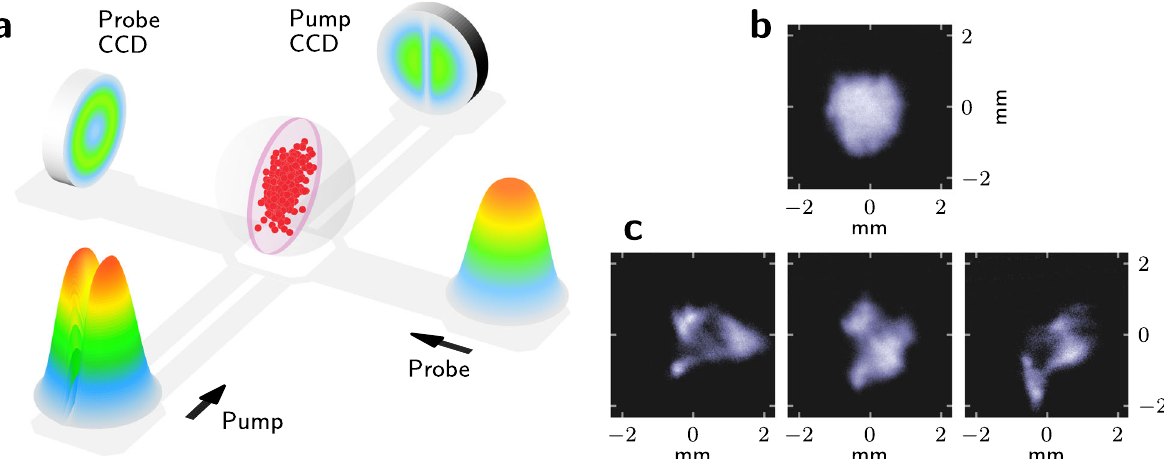
Fig. 1 Direct imaging scheme and unfolding of the turbulent regime. a Concept sketch illustrating the imaging working principle. The transversely carved pump beam induces a ground-state change in the atoms located in the outer shells of the cloud. A secondary beam propagating in an orthogonal direction then probes the remaining atoms located in a quasi-2D slab at the centre of the cloud. Typical atom density distributions in both the stable ( b ) and turbulent ( c ) regimes.